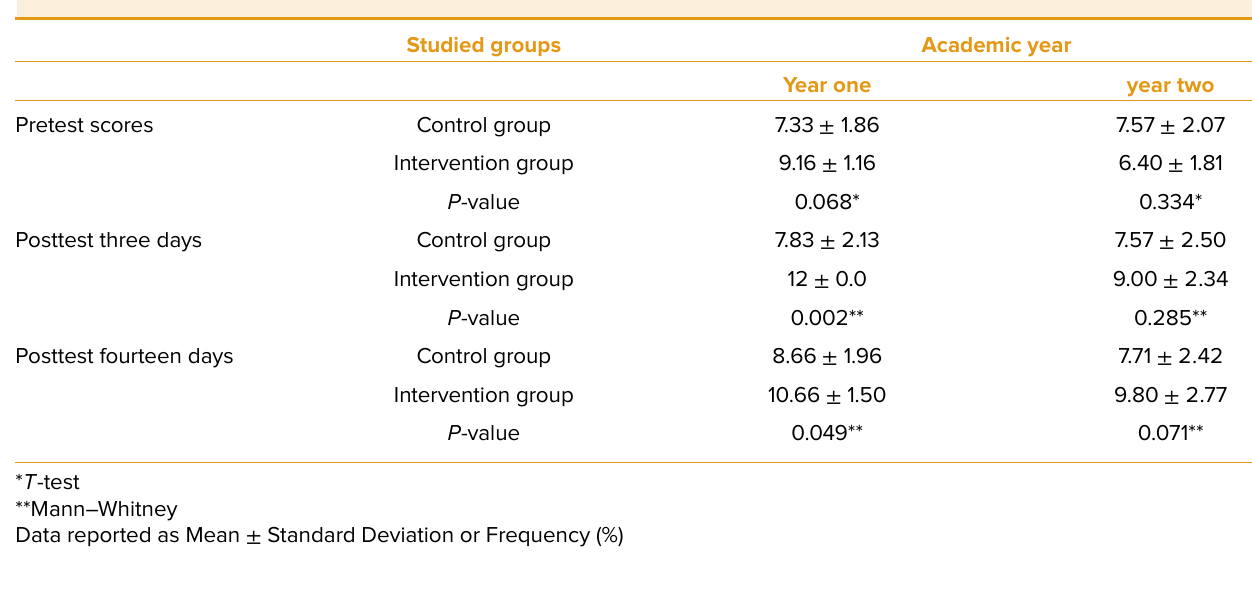
Table 3. Subgroup analysis based on the academic year